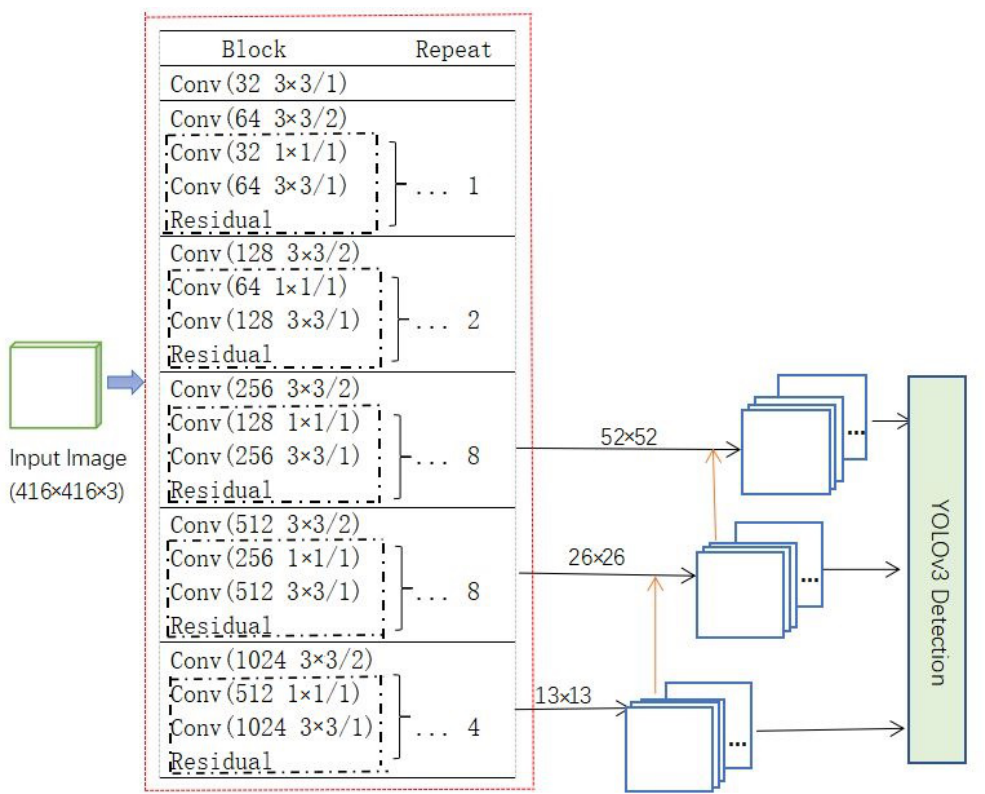
Figure 4. The architecture of YOLOv3. The red box part represents Darknet53 without fully connected layers, while the yellow arrow indicates upsampling. A convolution layer is denoted as (filters and filter size/step size).